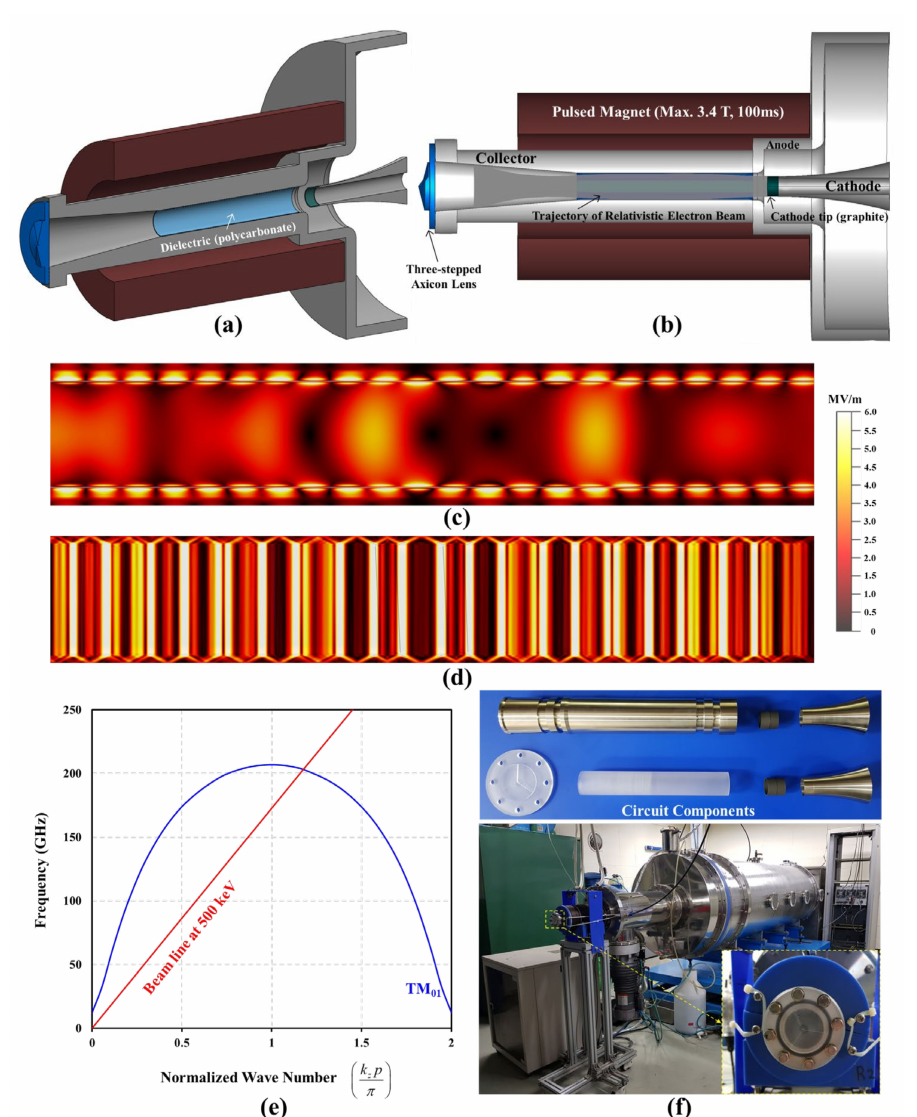
Figure 1. Millimeter wave (mmW) plasma wakefield accelerator system generating hyperfine energy- level splitting of positronium (Ps): ( a ) 3D modeling for outline, ( b ) beam trajectory interacting with mmW, ( c ) distribution of the gradient potential with the beam bunched adjacent to the dielectric ma- terial caused by the ponderomotive force induced via the non-uniform electromagnetic field applied to the plasma, ( d ) wakefields generated on the surface of a polycarbonate dielectric under conditions where Cherenkov radiation occurs, ( e ) the dispersion relation of a mmW plasma dielectric wakefield source, and ( f ) fabricated circuit components and plasma dielectric wakefield accelerator